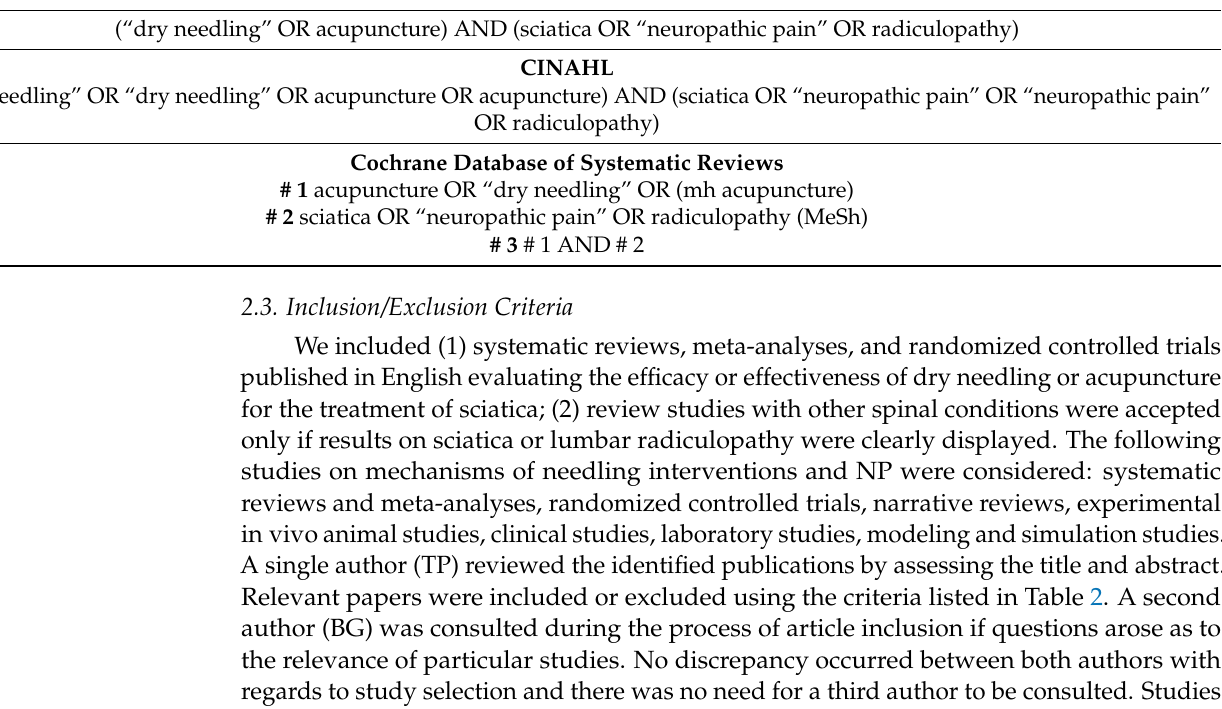
Table 1. Database formulas during literature search. PubMed/MEDLINE Search